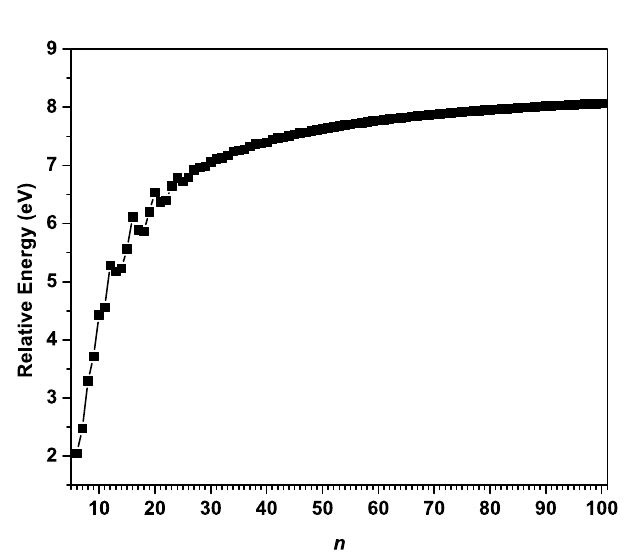
Figure 13. Relative energy of l -BNR[2, n ] with respect to c -BNR[2, n ] ( n = 6–100), obtained from spin- unrestricted